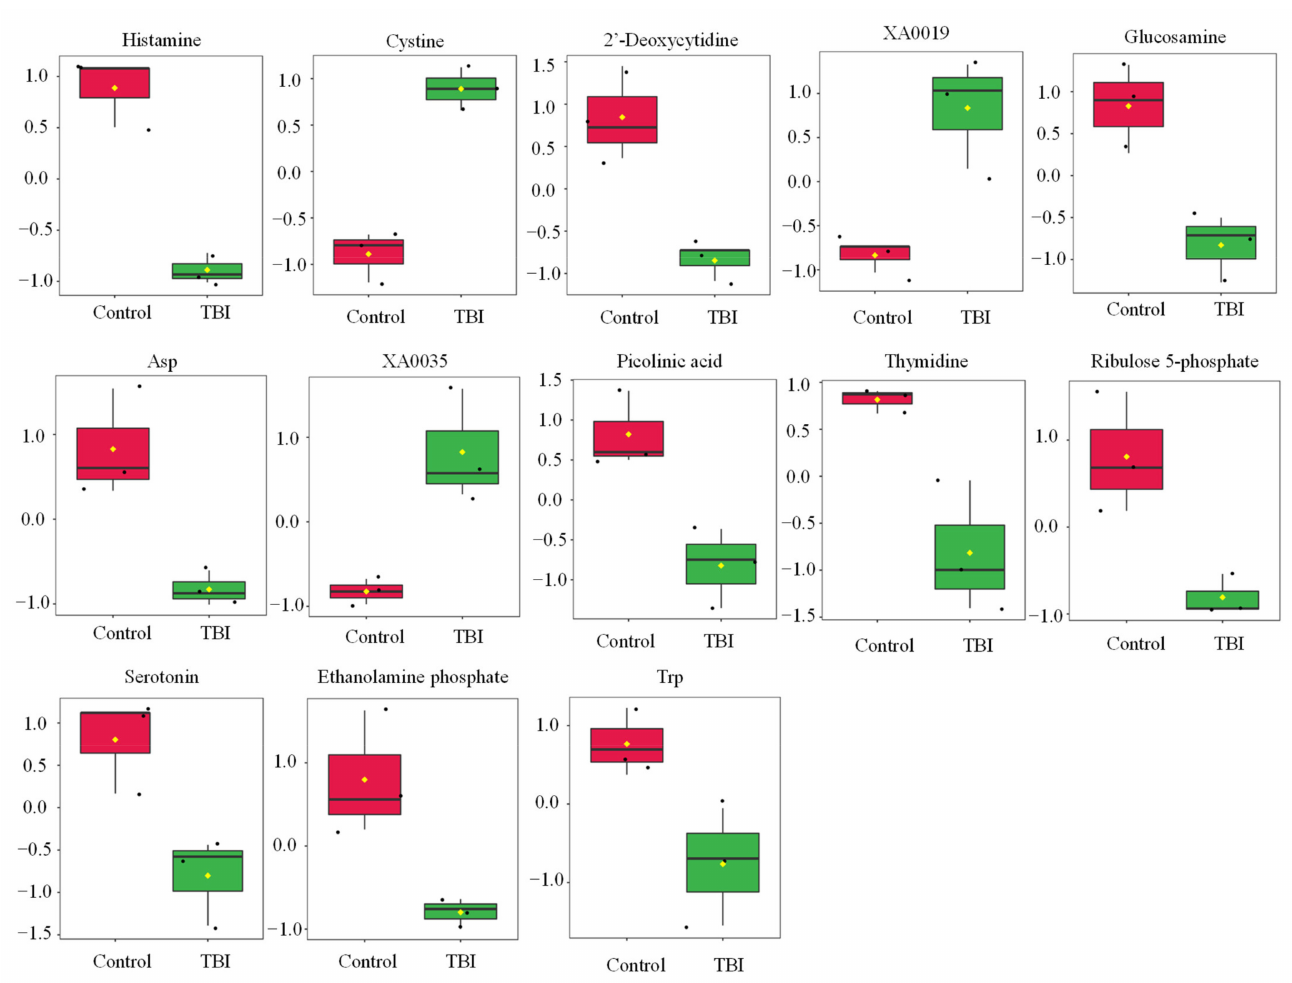
Figure 1. Effect of TBI on the metabolic profile in serum. Boxplots of metabolite were presented. The black dots represent the normalized value of metabolite. The notch indicates 95% confidence interval around the median. Asp—aspartate;